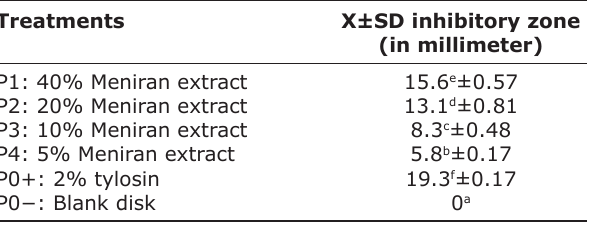
Table-1: Average and standard deviation of inhibitory zone diameter formed by the antibacterial Meniran extract against Salmonella pullorum